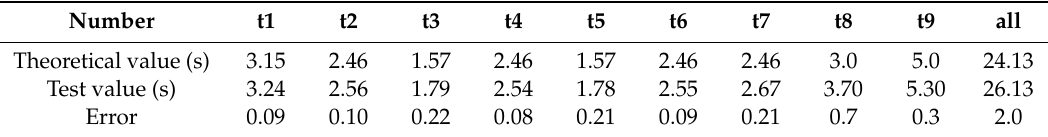
Table 2. Test on time consumption.